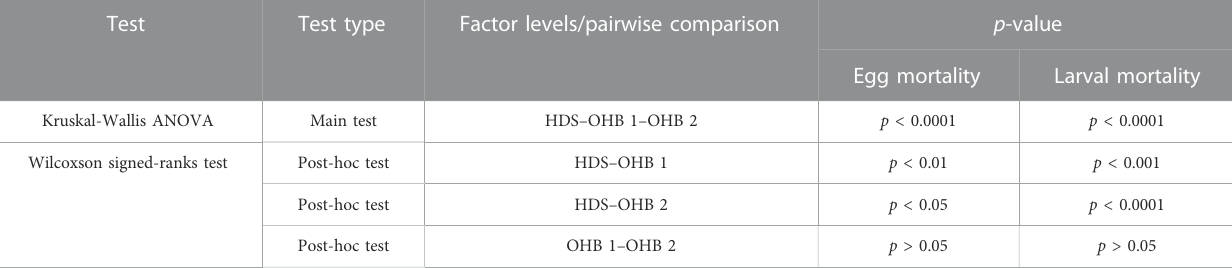
TABLE2Univariatecomparisonsofeggandlarvalmortalityforthethreedifferentspawninggrounds.HDS,groundwater-in fl uencedLängenmühlbach;OHB1and OHB2,non-groundwater-in fl uencedspawninggroundsintheOttheinrichbach.Kruskal-WallisANOVAdf=2.Wilcoxson-signedranks posthoc testwasBonferroni corrected for multiple comparisons.